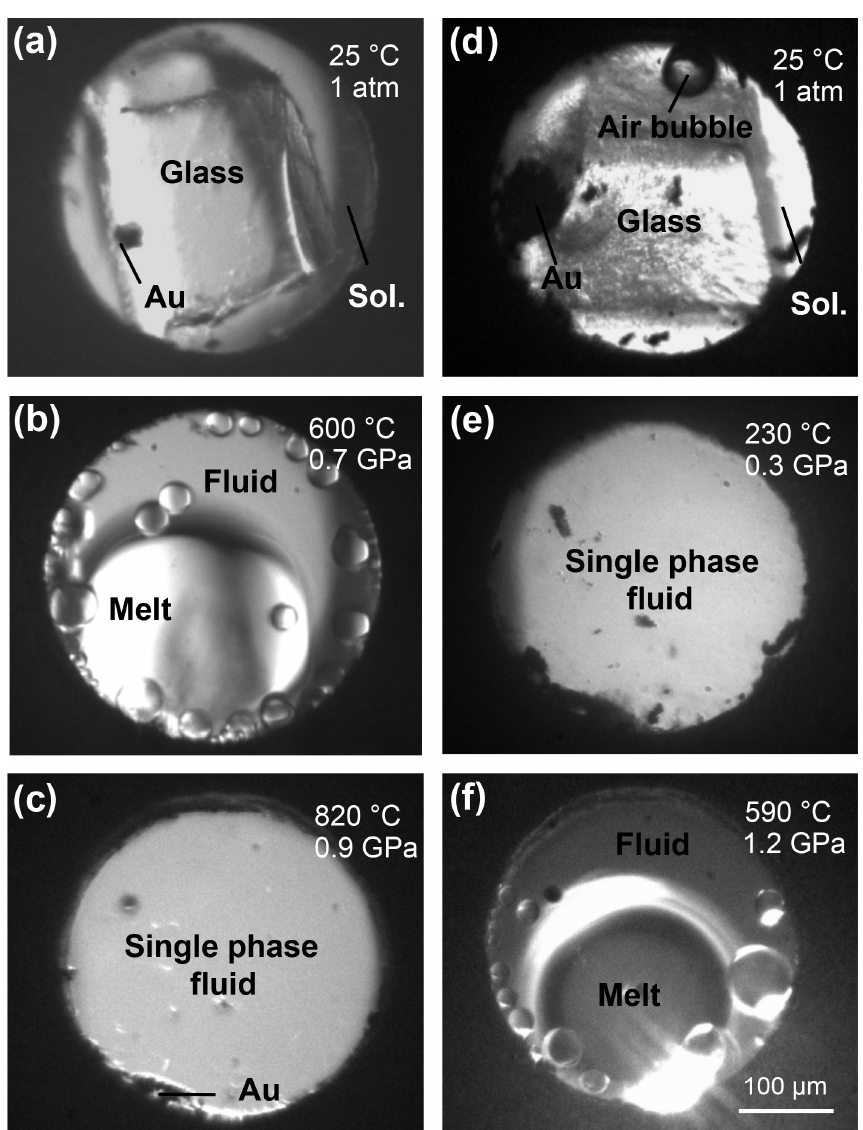
Figure 1. Microphotographs of the compression chamber of the HDAC showing the haplogranite–H 2 O (a, b, c) and NS2–H 2 O (d, e, f) systems at the indicated pressure and temperature conditions. Images are taken through the diamond along the x-ray path. (a) Haplogranite glass and 3wt% NaBr aqueous solution at room conditions; (b) globulus of hydrous silicate melt in equilibrium with the aqueous